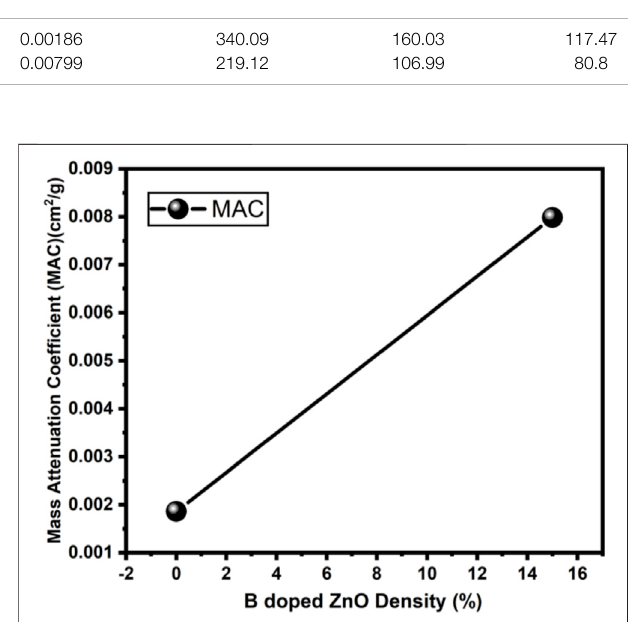
FIGURE 10 | Linear Attenuation Coef fi cient of B doped ZnO (0 and 15%).